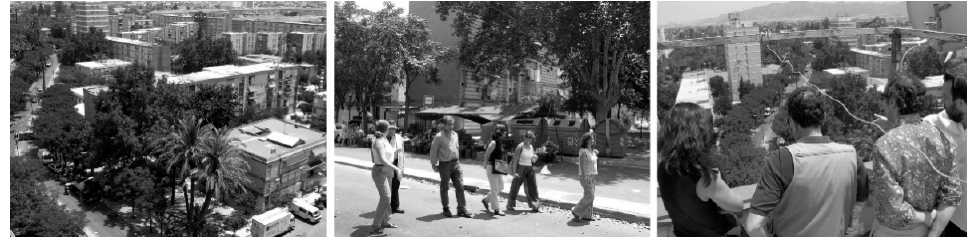
Figure 16. Taller Murcia 2.0 , La Paz, Murcia, Spain, working on site (2006). Courtesy of former